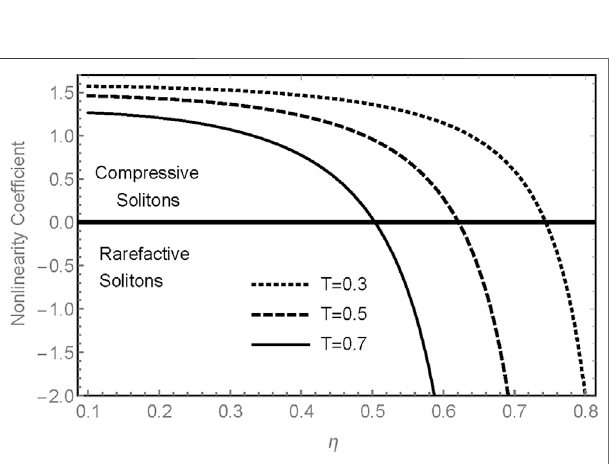
(cid:4)(cid:4)(cid:4)(cid:4)(cid:4) (cid:15) 1 − l 2 Z